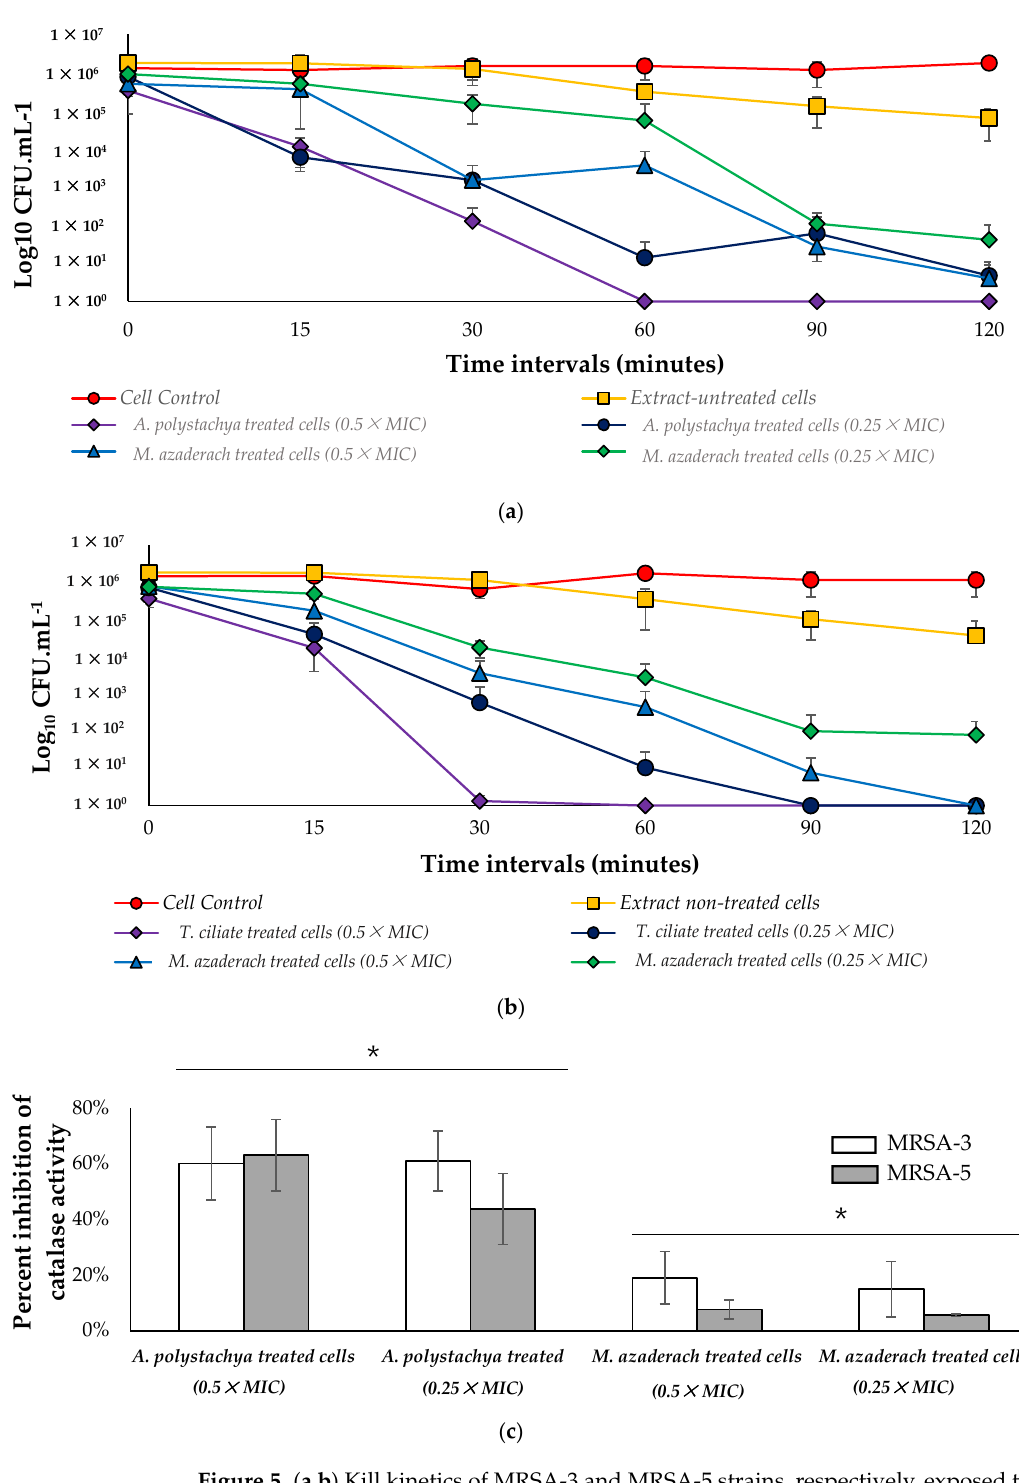
Figure 5. ( a , b ) Kill kinetics of MRSA-3 and MRSA-5 strains, respectively, exposed to 200 mM H 2 O 2 and pretreated with either Aphanamixis polystachya or Melia azedarach extracts within 120 min. Data represent the means of the viable colonies recovered at each time point ± SD, n = 3. ( c ) Inhibition of catalase enzyme activity in cells pretreated with either Aphanamixis polystachya or Melia azedarach extracts. Data represent the means of the height of the observed O 2 froth that remained constant for 15 min ± SD, n = 3. One-way ANOVA, followed by Tukey’s multiple comparisons, p -value < 0.0001). (*) Indicates presence of a statistically significant difference between